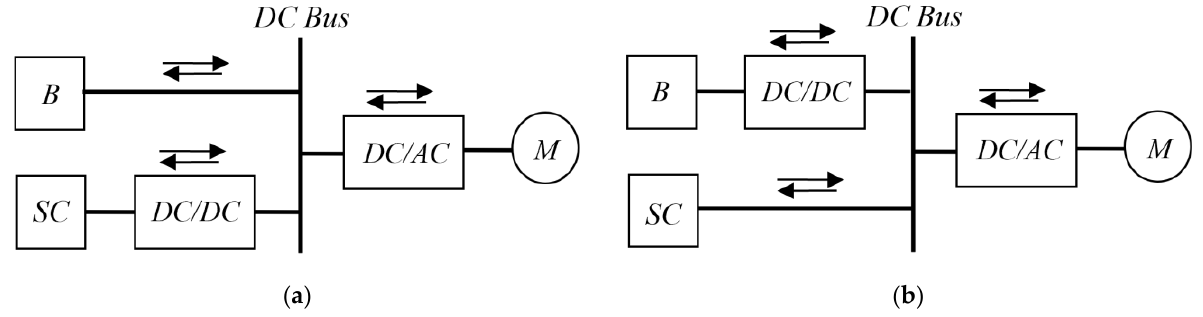
Figure 5. Combined vehicle system with a battery as the main power source: ( a ) first topology; ( b ) second topology.